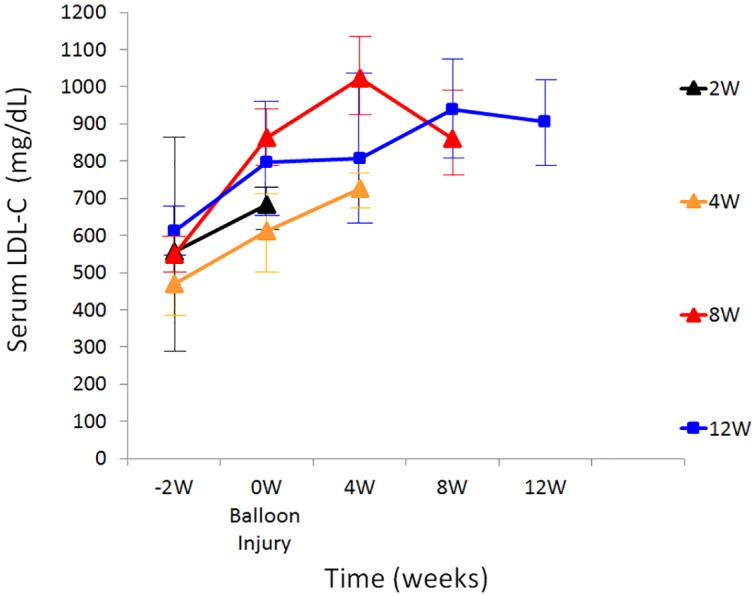
Time dependent changes in low density lipoprotein cholesterol levels in pigs fed with high-cholesterol/high-fat diet (n = 3 each, 12 in total).